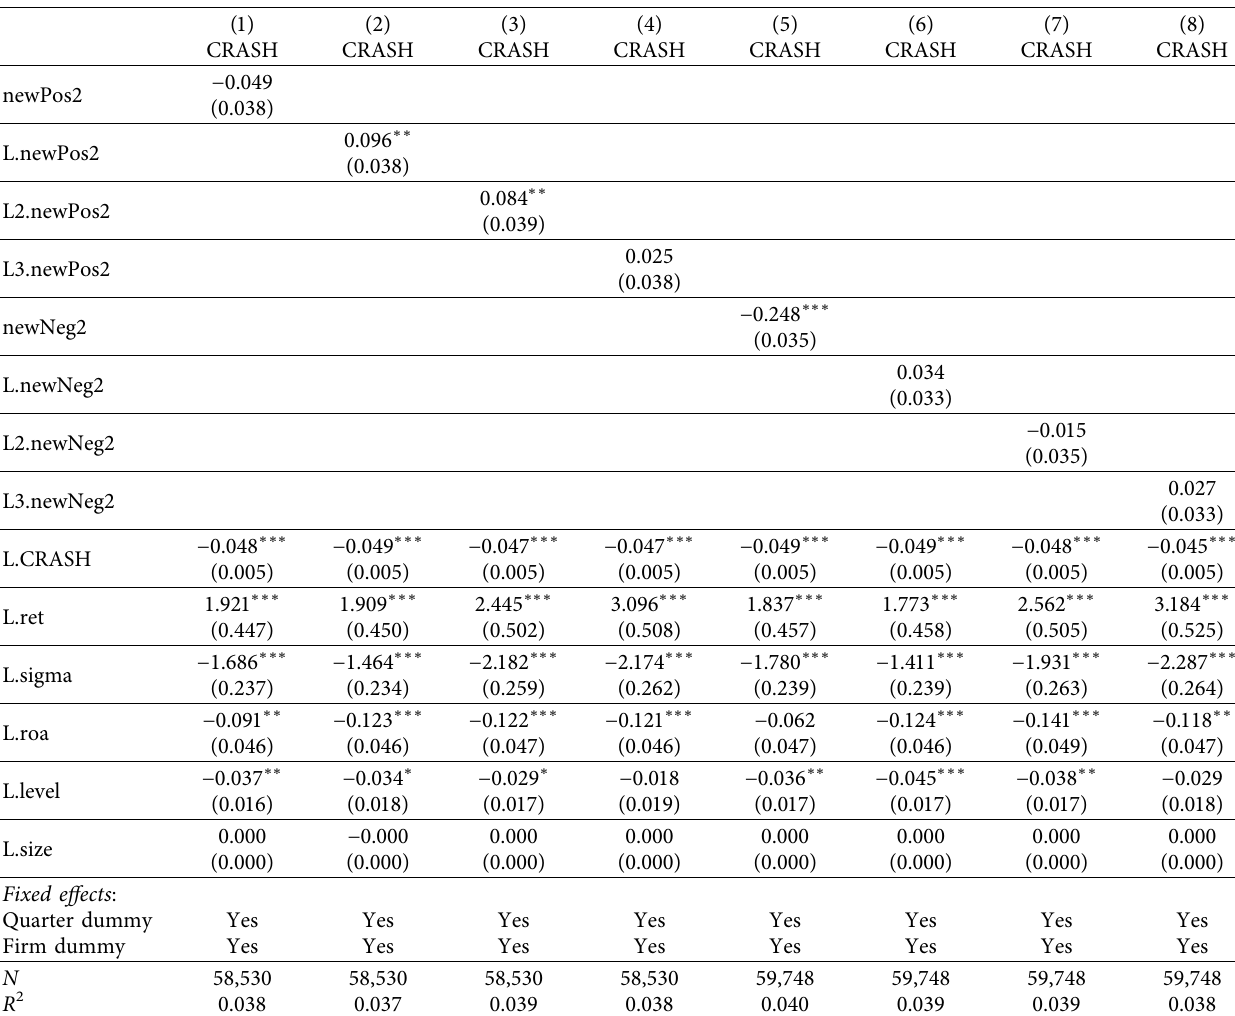
Table 16: Robust test: quarterly crash risk for different future periods.